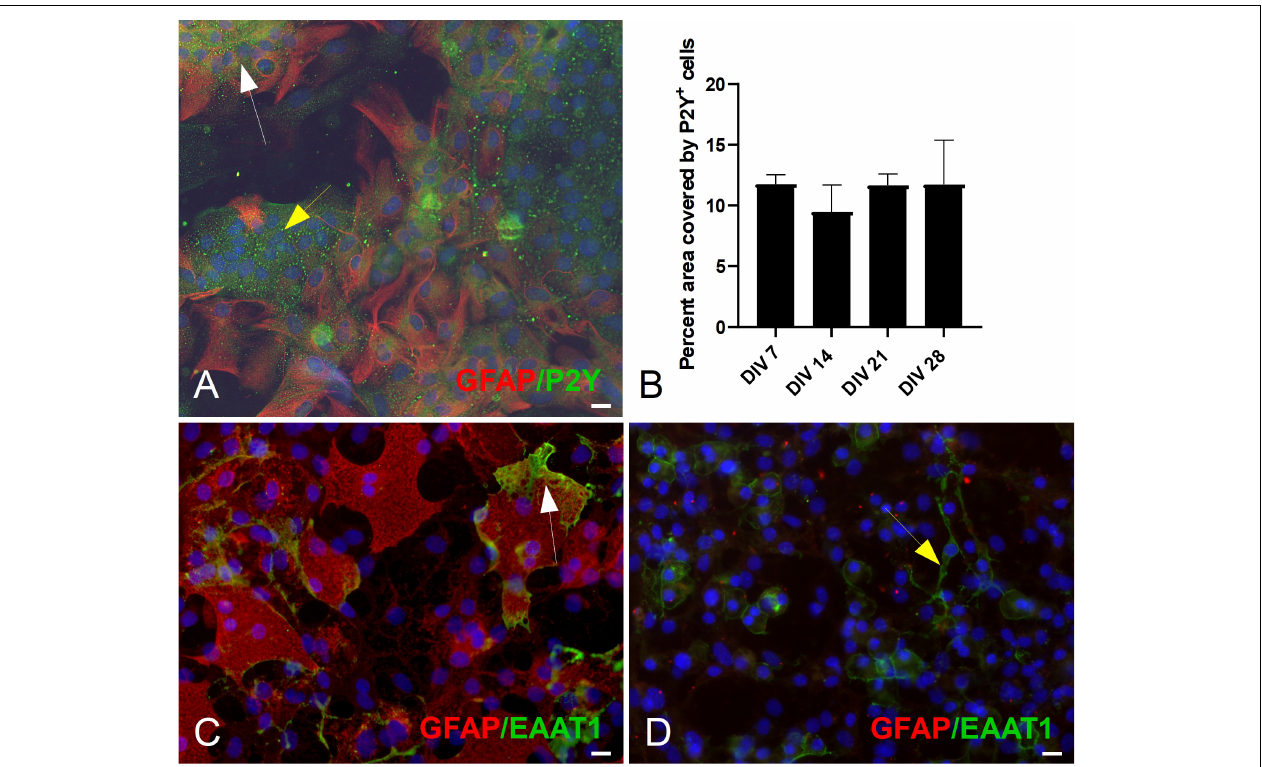
FIGURE 5 | Double ICC staining of mESC derived astrocytes for markers GFAP, P2Y 1 R. (A) Culture example at DIV 21 of GFAP + (white arrow) astrocytes and GFAP − cells (yellow arrow) expressing the metabotropic P2Y 1 R receptor. (B) Quantification of P2Y 1 R expression: percent (%) area covered by P2Y 1 R + cells. (C) Culture example at DIV 21 of GFAP + (white arrow) expressing the Glutamate Aspartate Transporter (GLAST, also known as EAAT1). (D) Culture example at DIV 21 of GFAP − (yellow arrow) expressing GLAST. Cell nuclei marker H-33342 (blue stain). Scale bars 20 µ